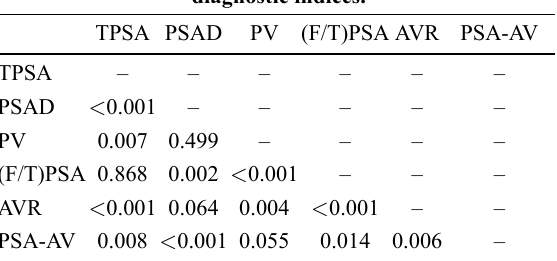
Table 3. AUROC value comparisons between each pair of diagnostic indices.